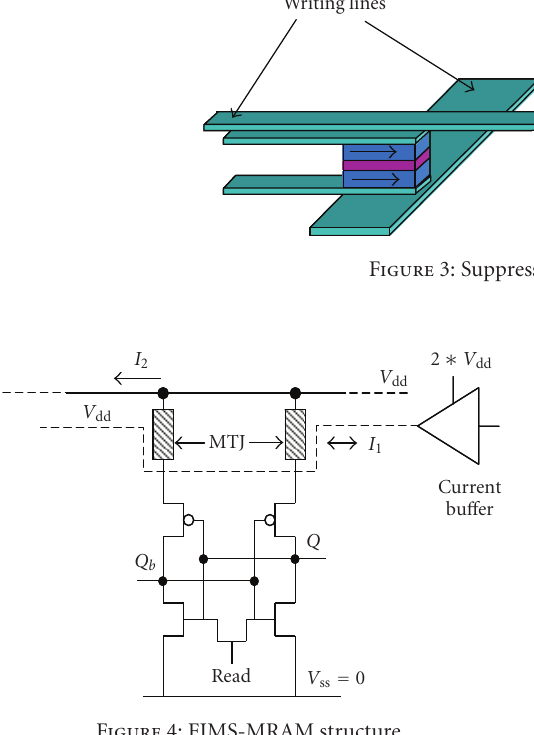
Figure 4: FIMS-MRAM structure.